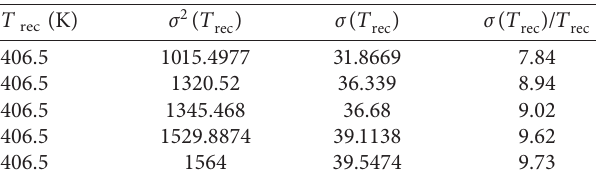
Table 6: Accuracy calculation results of the cold and ambient load method.